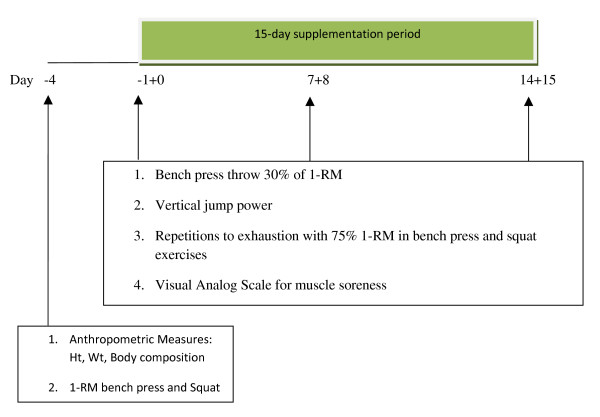
Schematic Diagram: Testing Protocol.